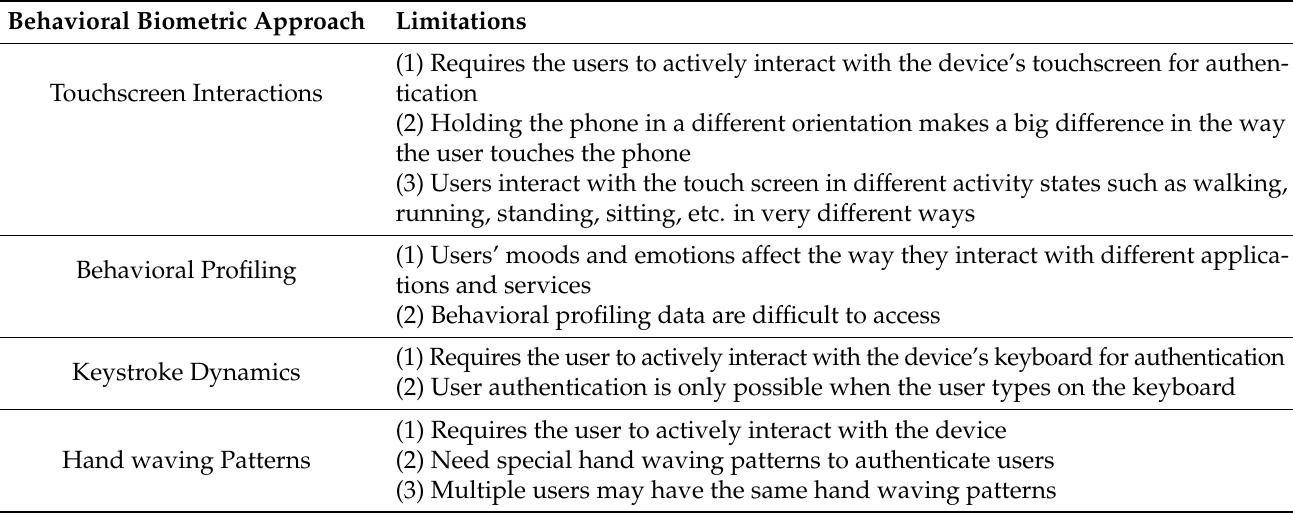
Table 1. Limitations of different behavioral biometric methods for mobile devices implicit